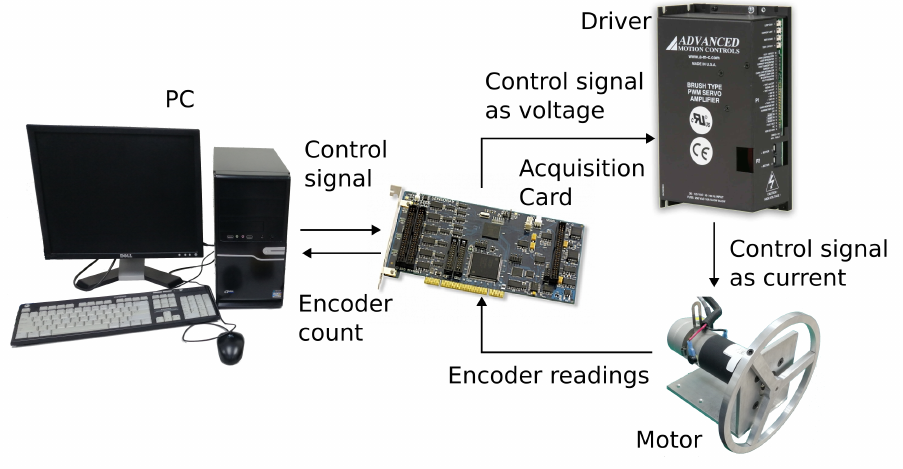
Figure 4. Experimental platform used for real-time